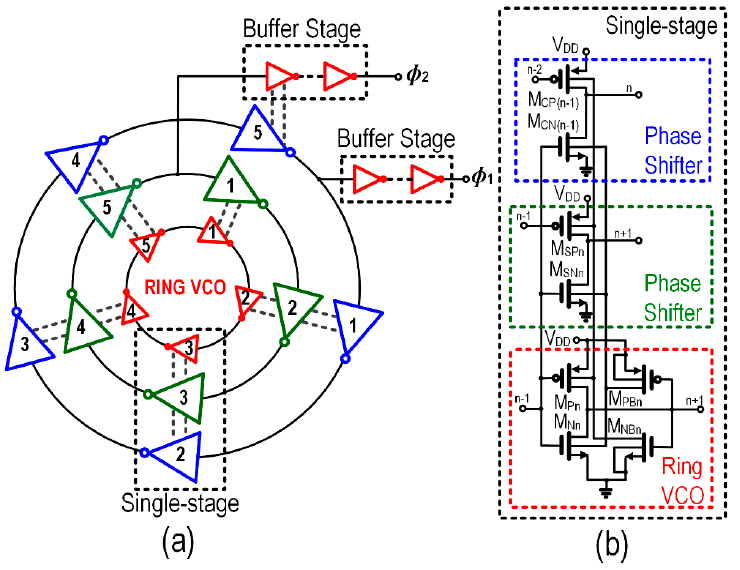
Figure 6. Details of the proposed 5 stages (N = 1, 2, . . . , 5) R VCO: ( a ) R VCO for energy harvesting, and ( b ) Shared-auxiliary-biasing ring-voltage-controlled-oscillator (SAB- R VCO).